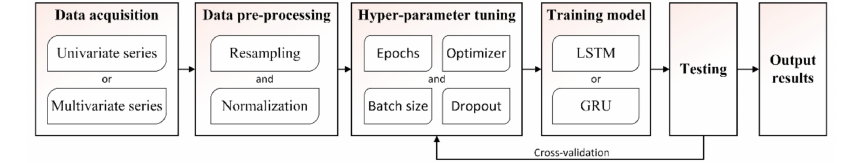
Figure 3. Scheme of the methodology.